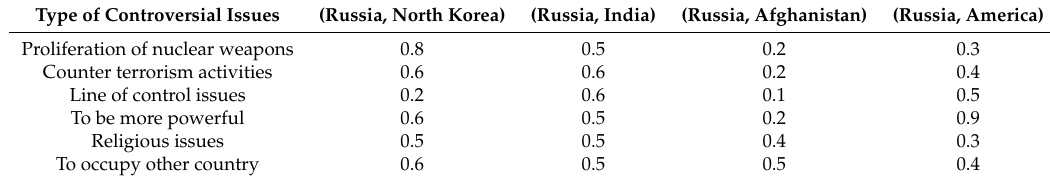
Table 3. Fuzzy set of controversial issues between Russia and other countries.